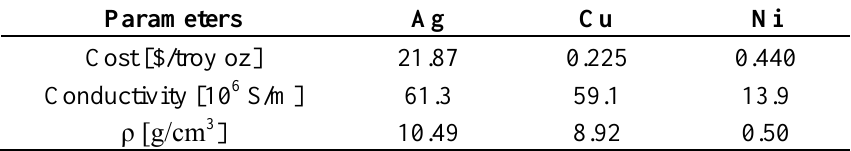
Table 1. Assessment of various metals costs and properties [31,32].